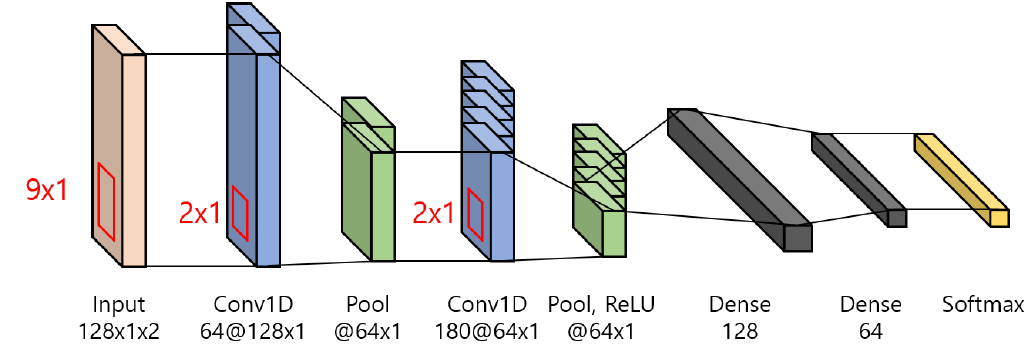
Figure 5. The CNN architecture of the proposed SIC scheme.